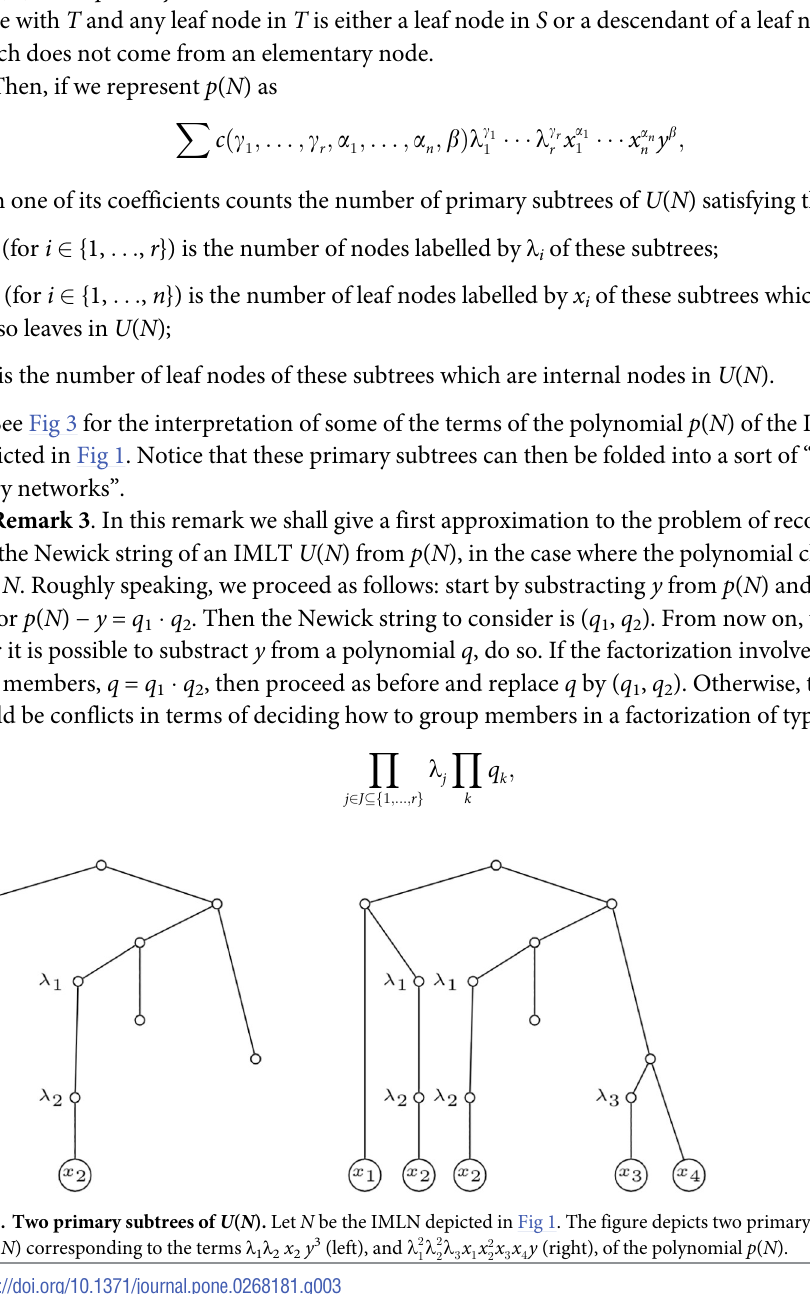
2 l 2 l x 3 x 4 y (right), of the polynomial p ( N ). 3 x 1 x 1 2 2